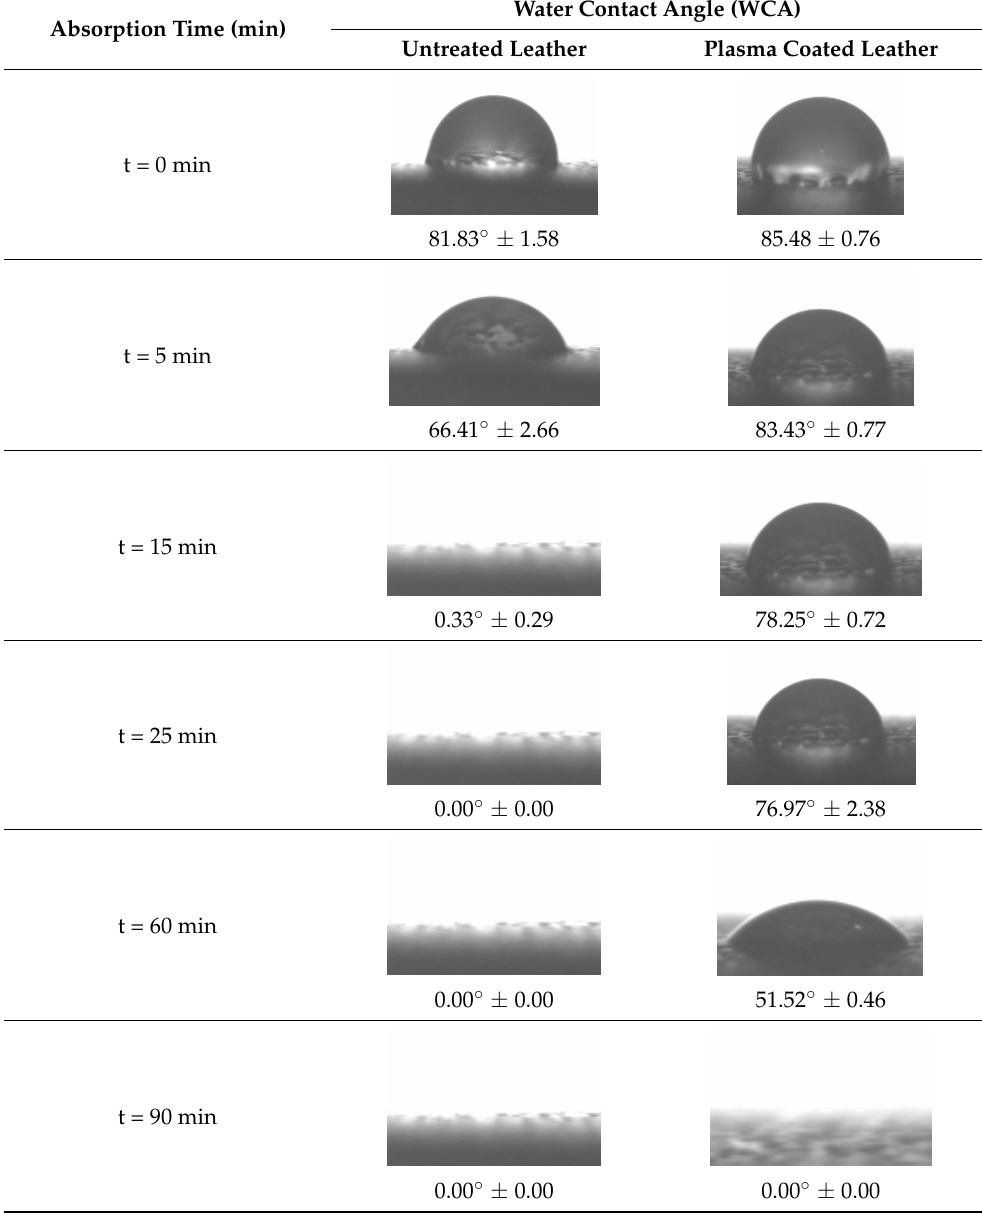
Table 7. Absorption time and contact angle in plasma treated and untreated leather samples. Absorption Time (min) Absorption Time